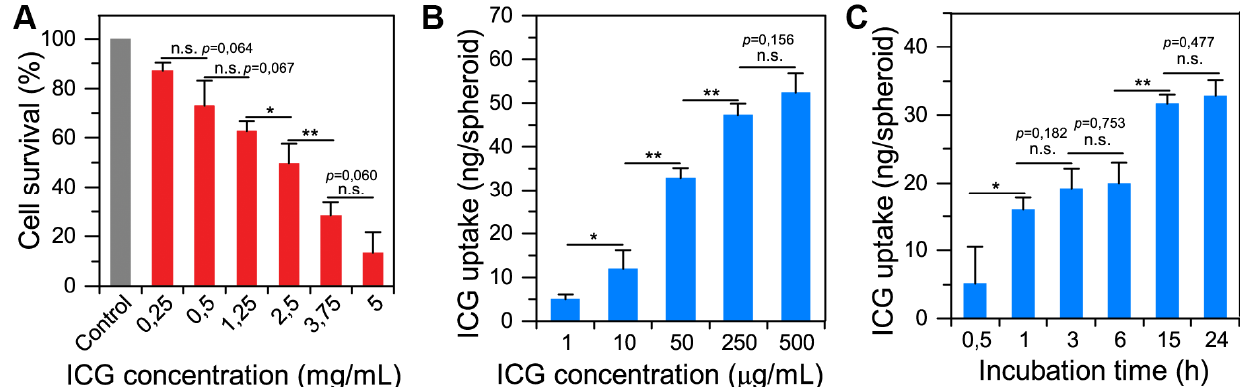
Figure 2. ( A ) Cytotoxicity of ICG on FaDu spheroids evaluated by clonogenic assays. After 24 h incubation with different concentrations of indocyanine green (0.25–5 mg/mL), cells were dissociated and seeded at 500 cells per well in plates. The wells were supplemented with RPMI medium and placed in the incubator for 10 days. The clones were then fixed with 70% ethanol and then stained with 1% crystal violet. The colony count was done with the naked eye. The results are presented as mean ± SD with n = 4. A * indicates a significant difference with p < 0.05. ** indicates a significant difference with p < 0.01. ( B ) Incorporation of ICG in FaDu spheroids after 24 h of incubation at different concentrations. FaDu spheroids were incubated 24 h with different concentrations of indocyanine green (1 µ g/mL–500 µ g/mL). After extraction, the fluorescence intensity was measured by a spectrofluorometer and was related to fluorescence calibration curves of ICG. The obtained ICG concentration was normalized to the number of spheroids. The results are presented as mean ± SD with n = 4. ( C ) Incorporation of ICG in FaDu spheroids after different incubation time. FaDu spheroids were incubated with 0.05 mg/mL of ICG for different durations (0.5–24 h). After extraction, the fluorescence intensity was measured by spectrofluorometer and was related to fluorescence calibration curves of ICG. The obtained ICG concentration was normalized to the number of spheroids. The results are presented as mean ± SD with n =